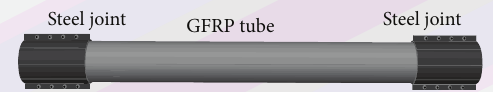
Steel jointSteel joint